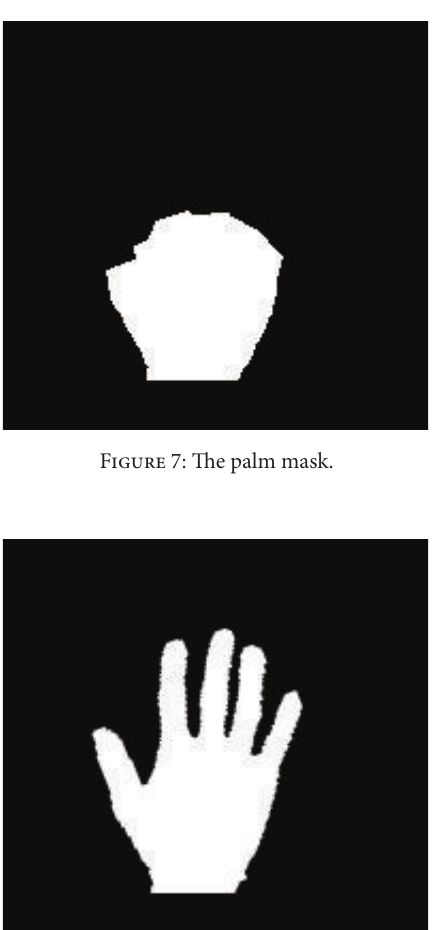
Figure 8: The rotated and cut hand